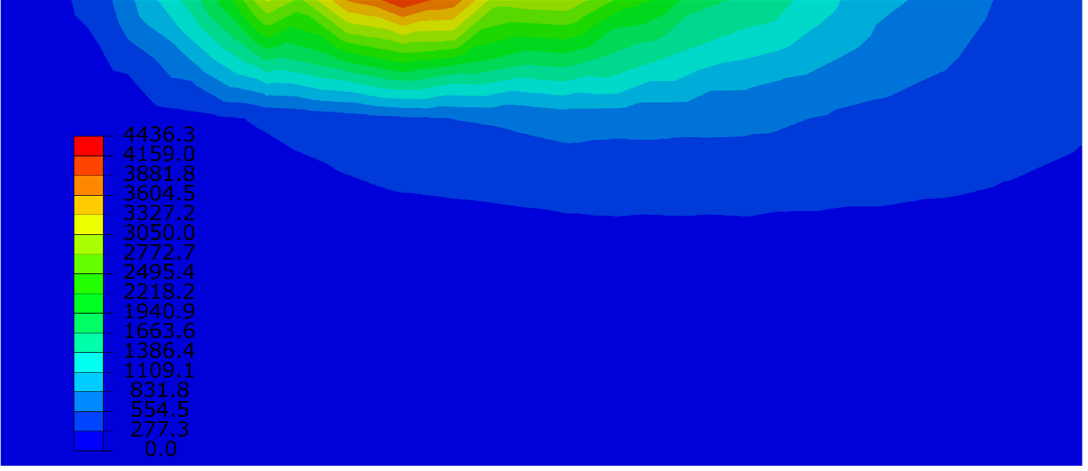
Figure 9. Temperature field variation of cut surface at 0.1 S.